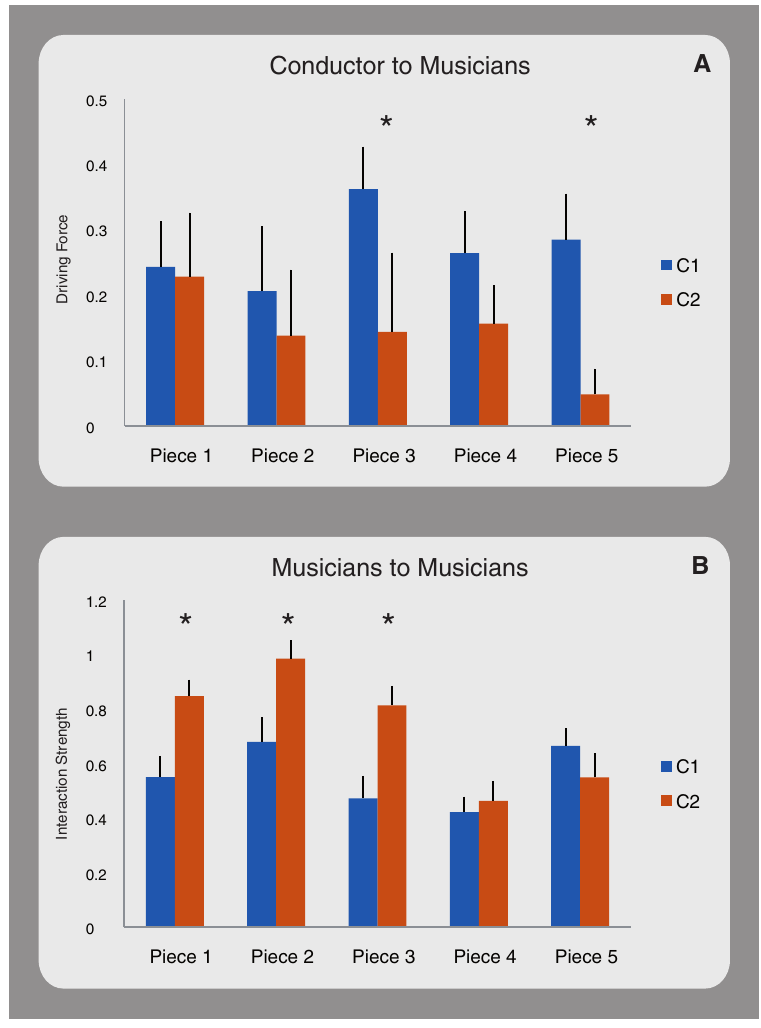
Figure 2. Conductor-to-musician, musician-to-musician communication. Conductor to musicians driving force (A), musician-to-musician interaction strength (B) are evaluated across musical pieces and shown in the upper two histograms. Bars show the standard error of the mean and asterisks denote significant differences.